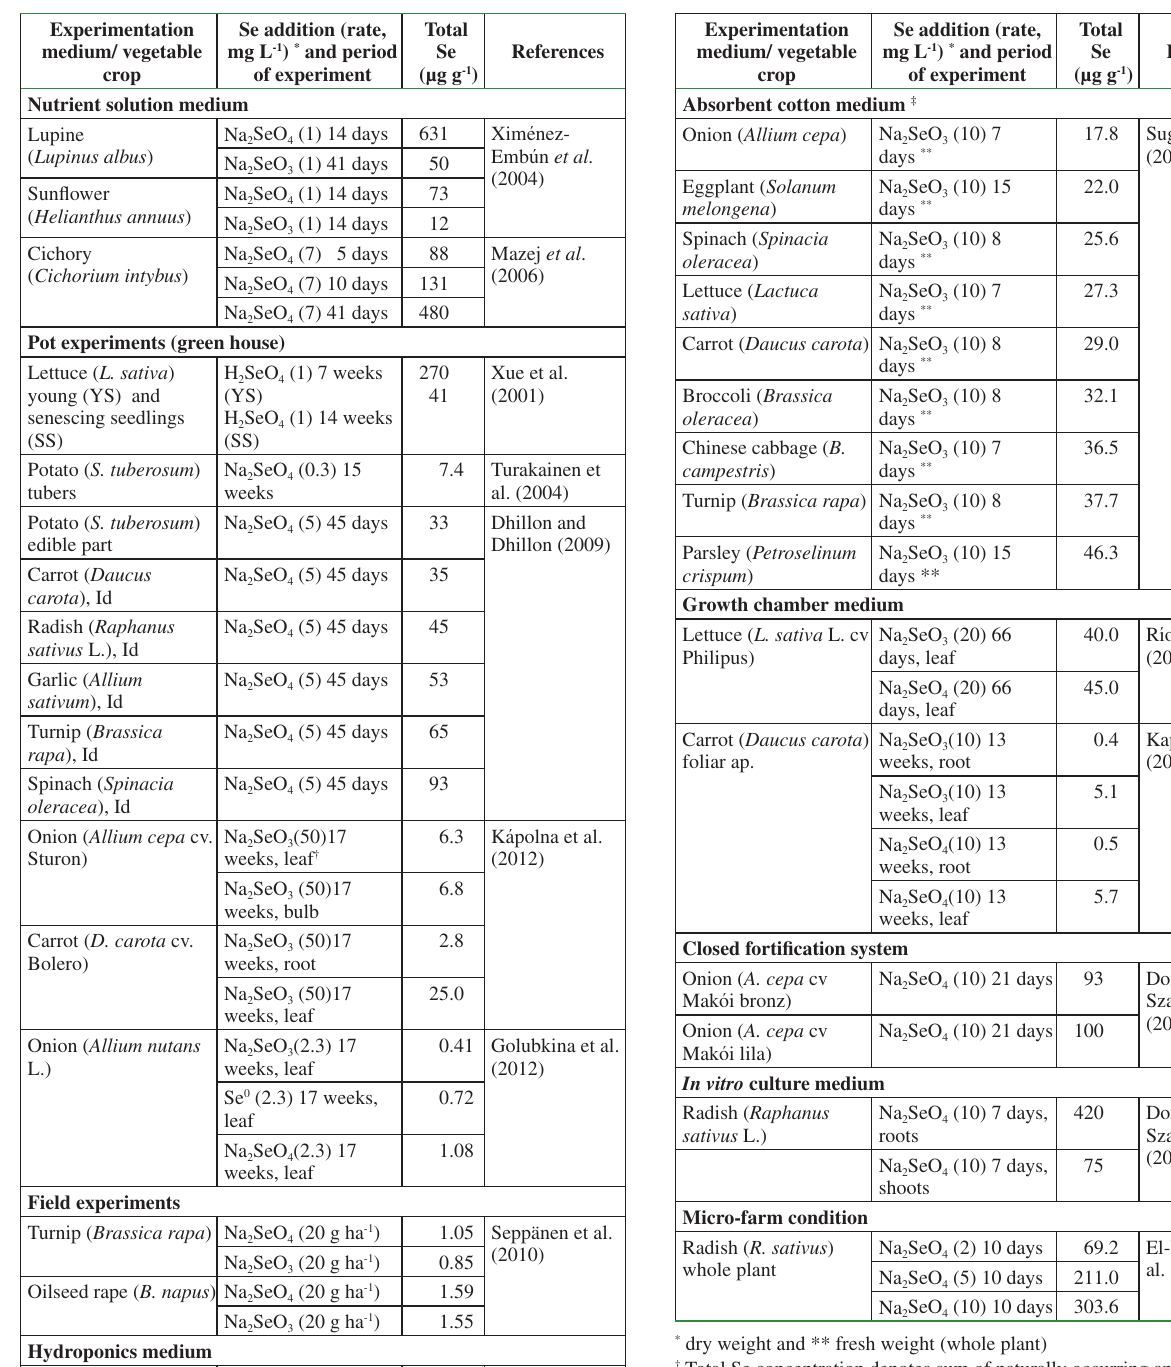
Table 1: Total concentration and forms of Se in leaves of cultivated crop plants exposed to Se under different experimental conditions as a result of fortification with different Se